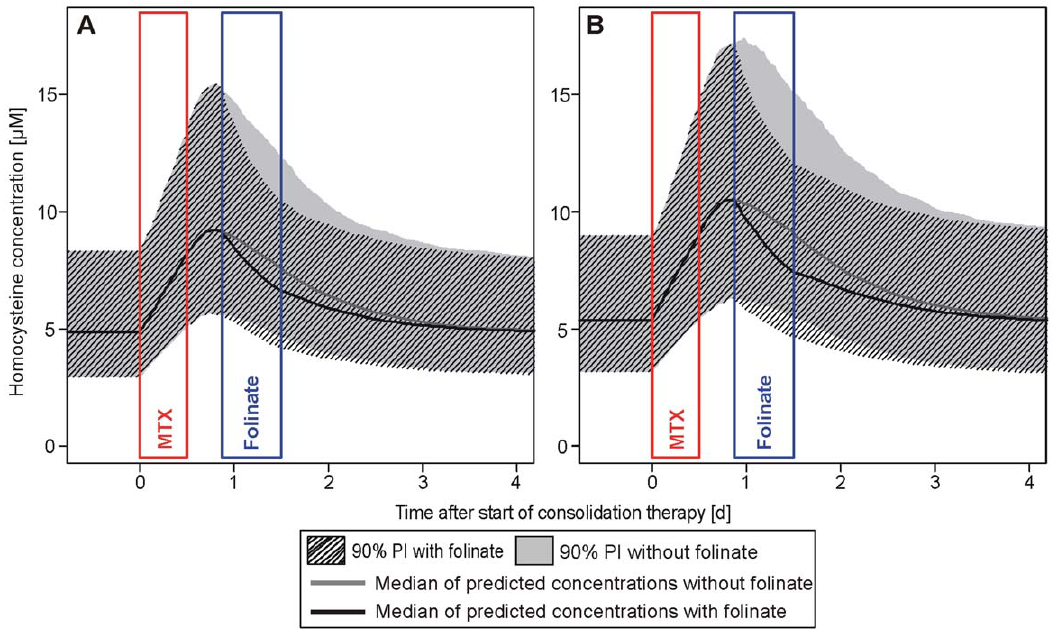
Figure 5. Homocysteine concentration-time courses with and without co-administration of folinate. Excerpt of 1000 per-protocol simulations each of the low-risk (A) and standard/high-risk (B) study population. The solid grey line represents the median of the simulations without folinate with the 90% prediction interval (PI) as solid grey area, the solid black line represents the median of the simulations under influence of folinate with the 90% PI as shaded area.